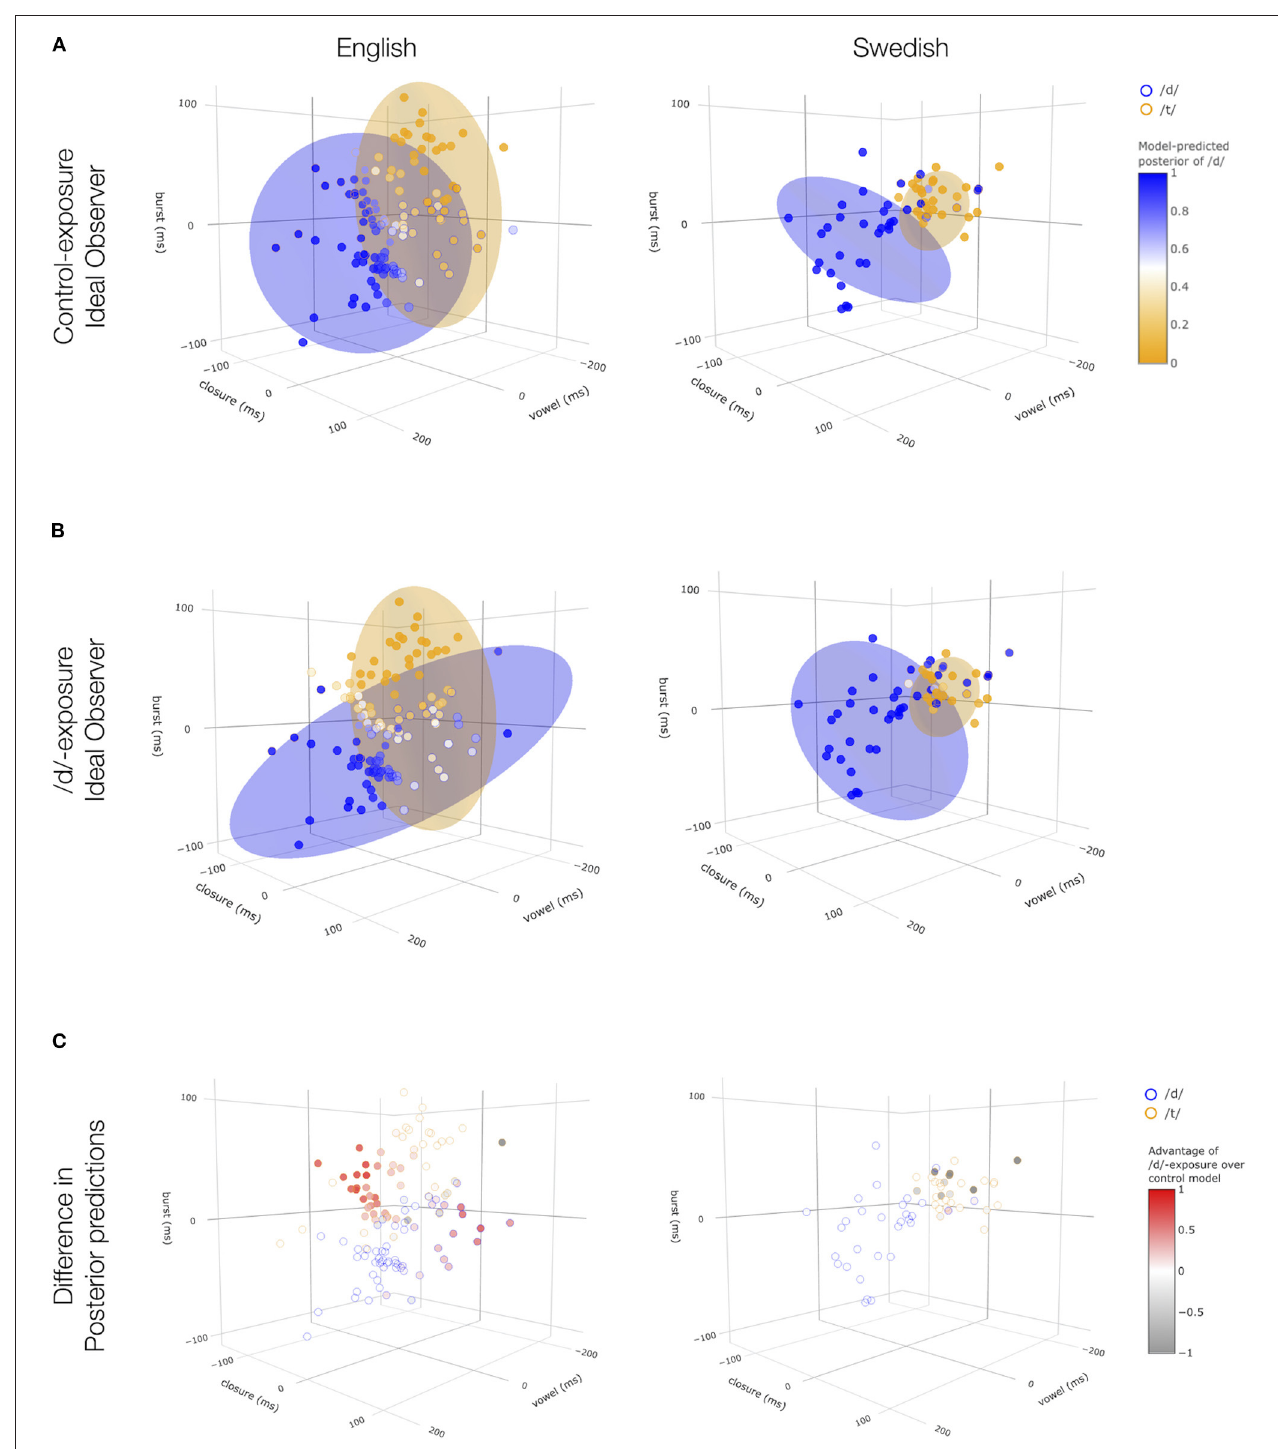
FIGURE 4 | Predicted ratings of control (A) and /d/-exposure ideal observers (B) , as well as their difference (C) shown for all test tokens. These models were constructed from the distributions shown in Supplementary Material (section 4.3.2) so as to simulate a learner who has either been exposed to, and perfectly learned, the statistics of the non-native /d/ (/d/-exposure model) or has not been exposed to non-native /d/ and thus assumes native /d/ statistics (control model). Ellipses visualize the category likelihoods assumed by the respective ideal observers (specifically 95% of the probability density). Across all panels, the outline color of points indicate their intended category. In (A,B) , the degree of color match between a point’s outline color and fill color indicates a more accurate prediction matching the intended category. In (C) , the color fill of points indicate the difference in posterior predictions between the /d/-exposure and control exposure models: redness indicates better performance in the /d/-exposure model (relative to control) and grayness indicates the opposite pattern. See Supplementary Material (section 5.3) for interactive visualization.